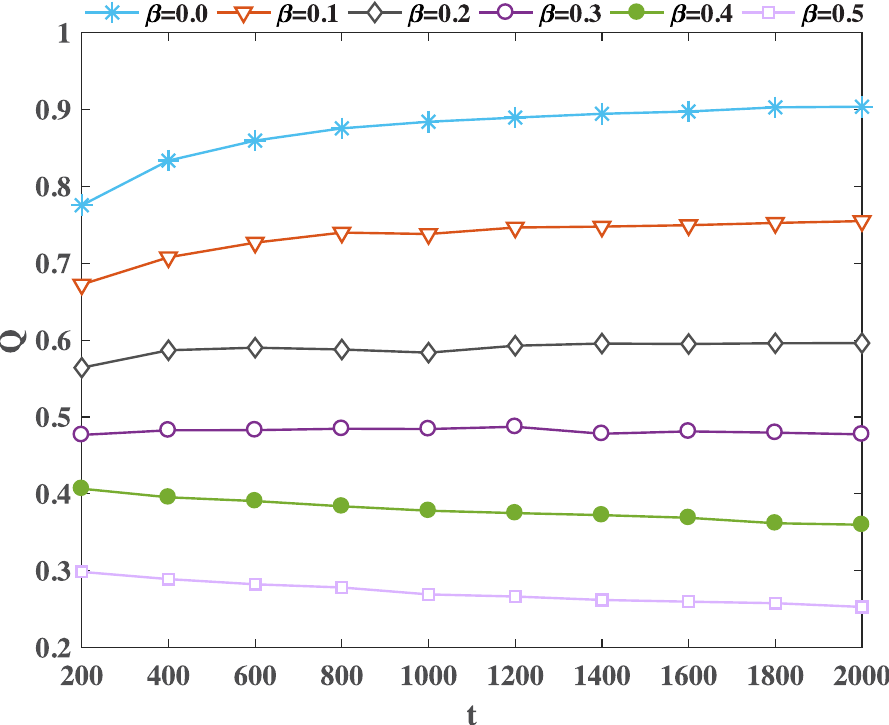
Fig 4. Modularity index, Q, is plotted for different size of networks generated by the proposed model with different values of β . Horizontal-axis represents the number of nodes in the networks and the vertical-axis represents modularity index of the